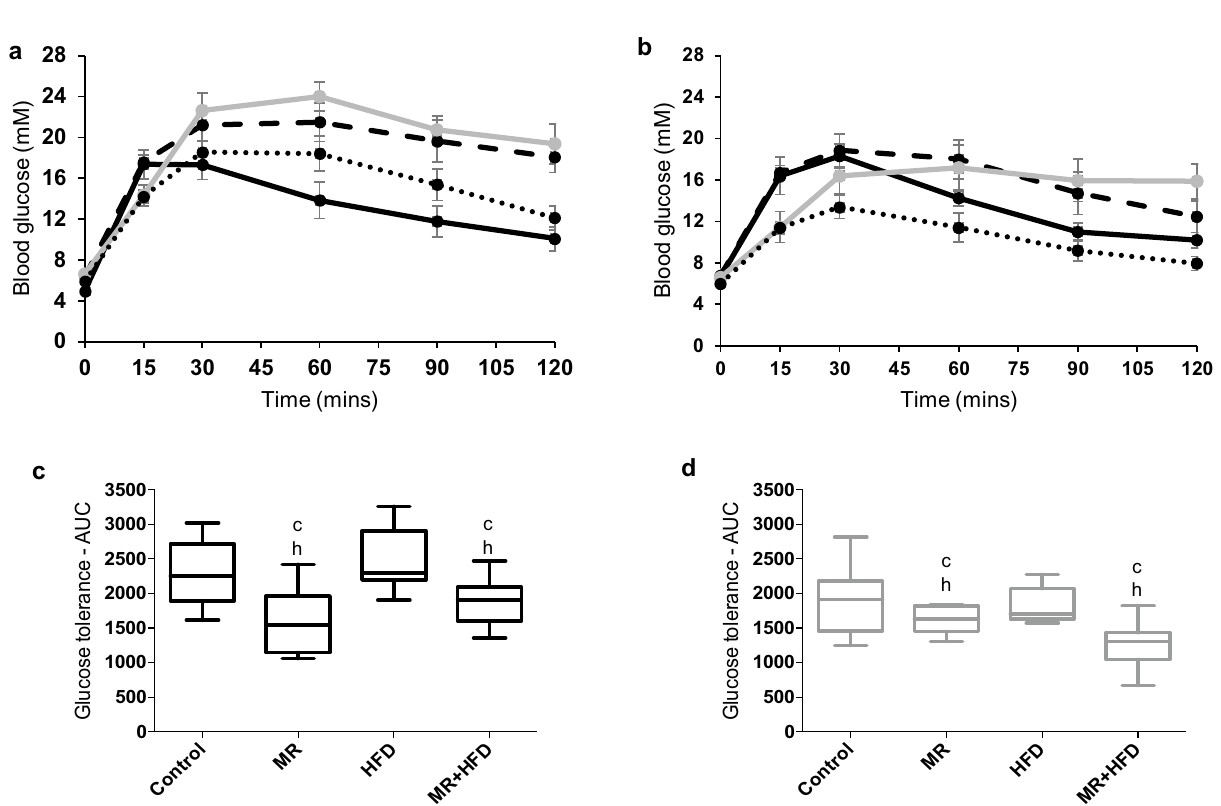
Figure 2. Glucose tolerance. Blood glucose concentrations (mM) measured at 0, 15, 30, 60, 90, 120 min after an intraperitoneal injection of 2 g glucose per kg body mass glucose in ( a ) young and ( b ) old mice fed control, methionine restricted (MR), high fat diet (HFD), or MR + HFD diet. The area under the curve calculated from glucose concentrations in ( c ) young and ( d ) old mice and c, h: significantly different from control and HFD groups respectively at p ≤ 0.003. Data is presented as ( a , b ) mean, min, max and ( c , d ) mean ± Glucose tolerance. Figure 2a,b show the time course of changes in blood glucose concentrations after a bolus injection of glucose. It can be seen in Fig. 2c,d that, irrespective of age, animals on MR and MR + HFD had a better glucose tolerance compared to the control and HFD groups (p ≤ 0.003). Muscle mass. Figure 3 shows the mass of control m. gastrocnemius (Fig. 3a), m. soleus (Fig. 3b) and m. plantaris (Fig. 3c) in young and old mice fed control, MR, HFD and MR + HFD diets. The mass of the m. gas- trocnemius was higher in young than old animals (p < 0.001). The MR and MR + HFD groups had a lower m. gastrocnemius mass compared to the control and HFD groups (p < 0.001), irrespective of age. Young animals had a larger m. soleus mass than old (p < 0.001; Fig. 3b). There was, however, an age × diet interaction (p = 0.030) for the m. soleus mass. In the young animals the mass of the soleus was higher in mice on a HFD than that in control, MR and MR + HFD groups (p < 0.001). In old animals the soleus muscle mass was also higher in animals on a HFD than on MR and MR + HFD (p < 0.001), but there was no significant difference